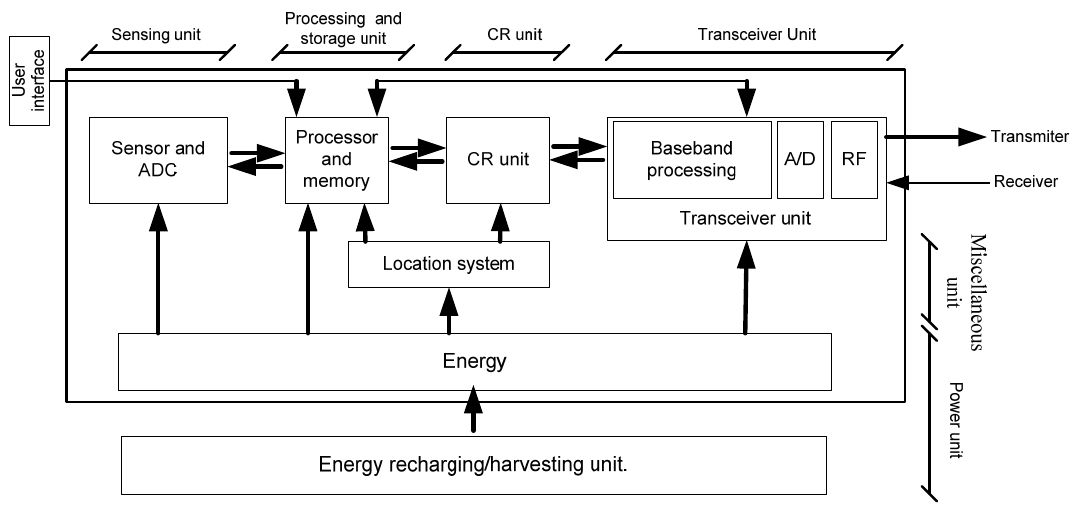
Figure 4. Hardware structure of CR wireless